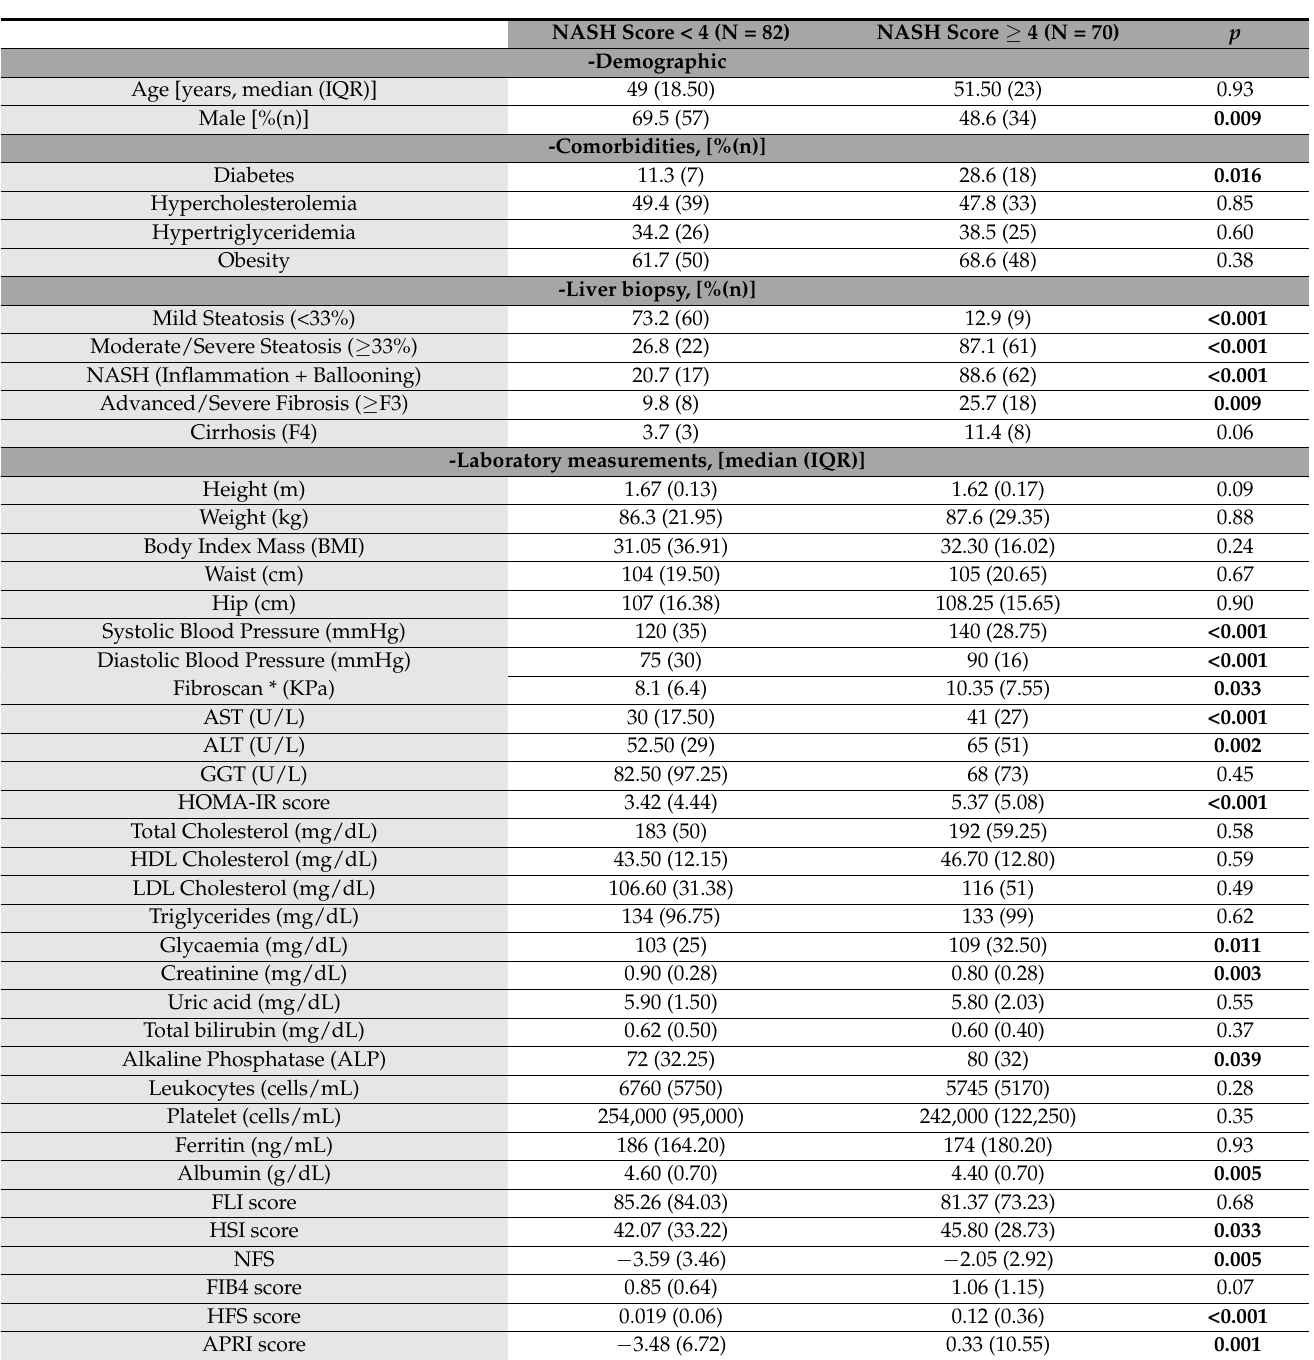
Table 1. Clinical characteristics of NAFLD patients split by a NASH score of 4. Continuous variables are represented as [median, (interquartile range, IQR)]; categorical variables are represented as [%, (n)]. HOMA-IR, Homeostatic Model Assessment for Insulin Resistance; AST, Aspartate Aminotransferase; ALT, Alanine Aminotransferase; GGT, Gamma-glutamyl transferase; FLI, Fatty Liver Index; HSI, Hepatic Steatosis Index; NFS, Non-Alcoholic Fatty Liver Disease fibrosis score; FIB4, Fibrosis-4; HFS, Hepamet Fibrosis Score; APRI, AST to Platelet Ratio Index. NASH Score < 4 (N =